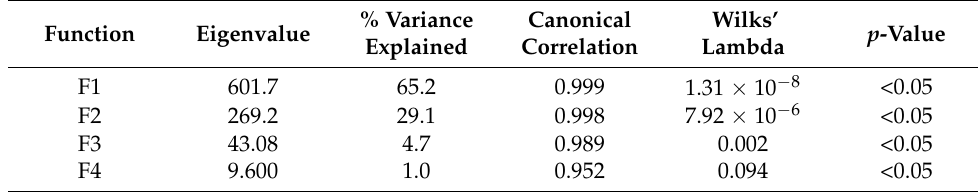
Table 8. Results of discriminant function analysis.